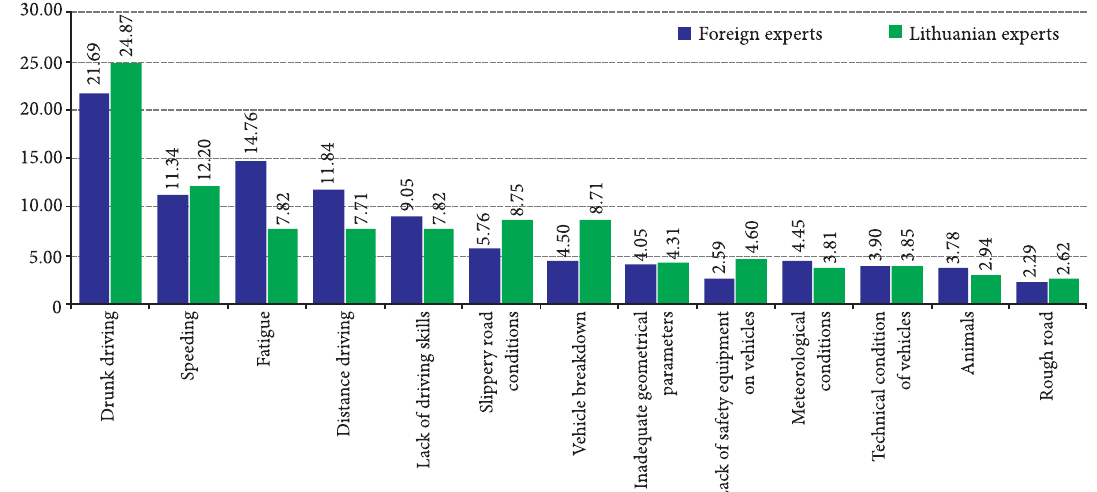
Fig. 3. Distribution of foreign and Lithuanian experts’ opinion on the causes of road accidents